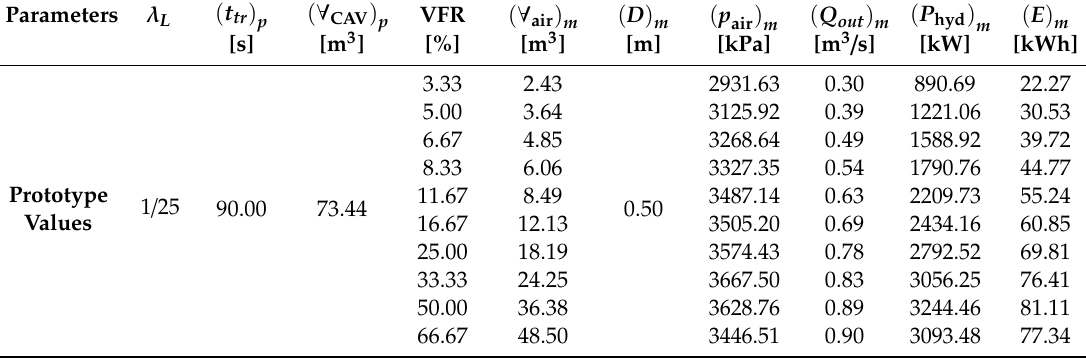
Table 6. Scaled-up parameters for a prototype with length-scale 1 / 25 and di ff erent VFRs.